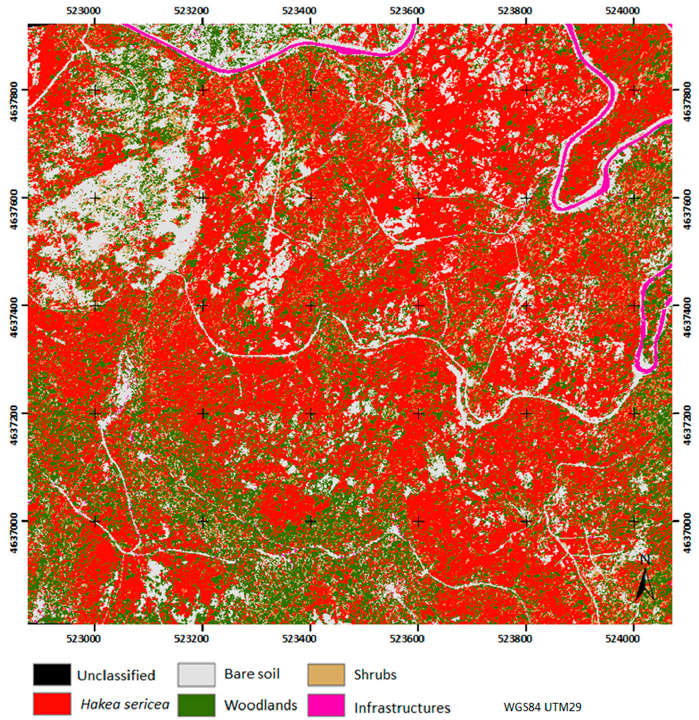
Figure 4. Map of land cover classes using UAV orthoimages (1 August 2013) and dataset “Basic 1”. Note: Hakea sericea is mapped in red. Table 5. Characteristics of the selected feature spaces for classifying the WV2 image and the UAV orthoimages.